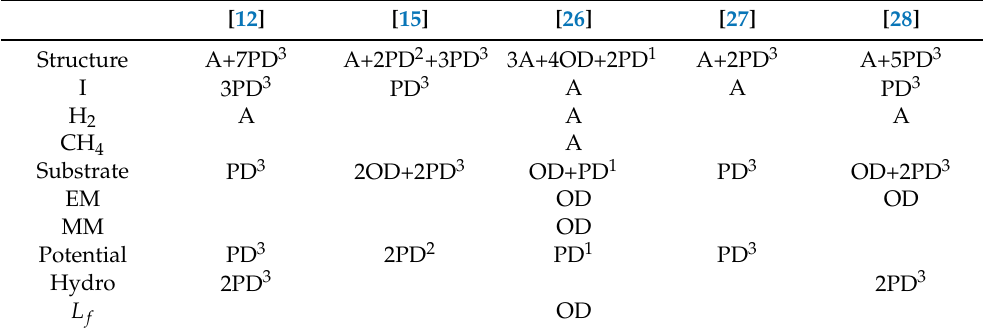
Table 2. Microbial electrolysis cell model classification based on partial differential algebraic equation